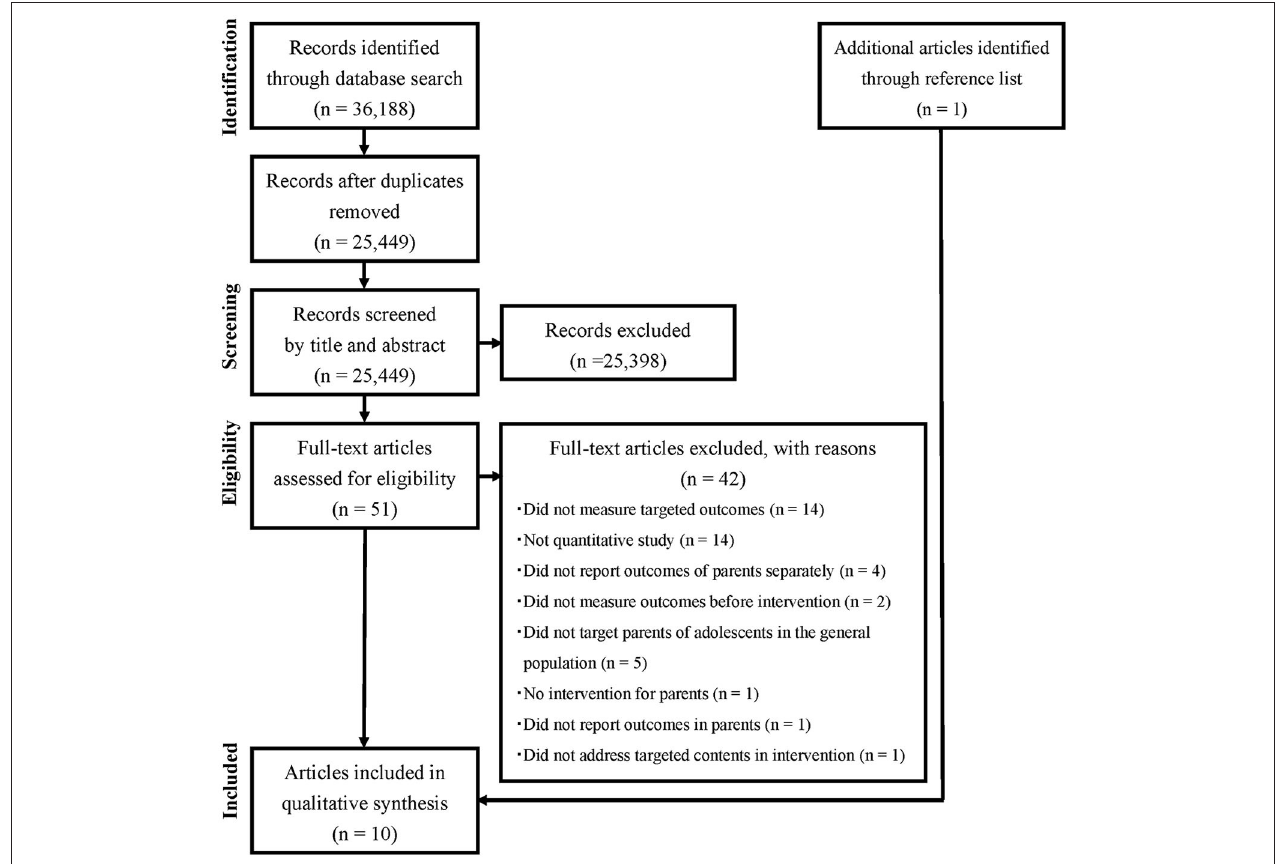
FIGURE 1 | Flow chart of article selection